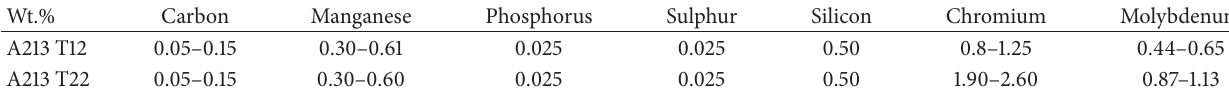
Table 1: Chemical composition of low-alloy steel: ASTM A213 T12 and A213 T22.